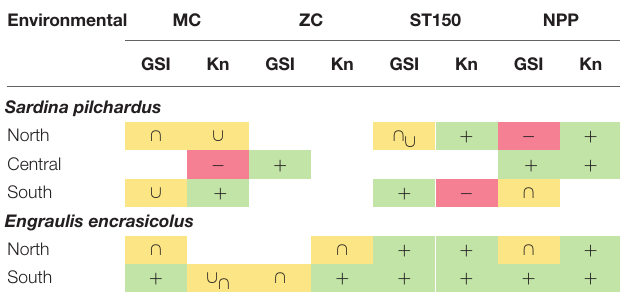
TABLE 3 | Summary table of the relationship of gonadosomatic index (GSI) and body condition index (Kn) of sardine ( Sardina pilchardus ) and anchovy ( Engraulis